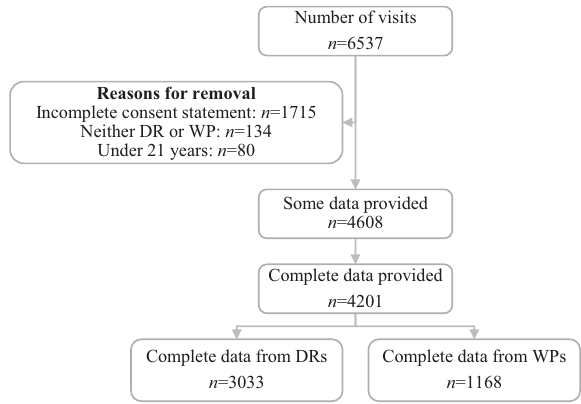
Fig. 1 CONSORT diagram of sample sizes and reasons that data